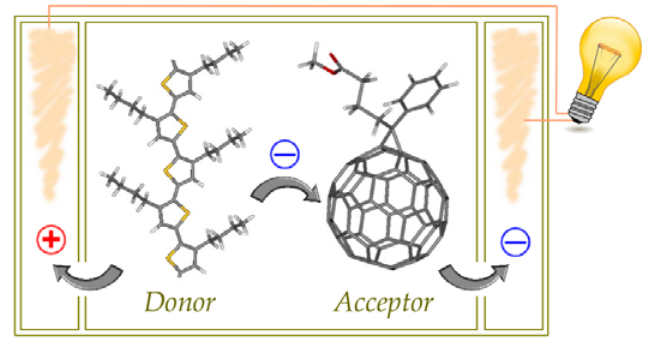
Fig. 1. Scheme of an organic solar cell and molecular structures of regioregular P3BT (left) and PCBM (right). “Regioregular” means that P3BT’s monomers are enchained in a regular head-to-tail